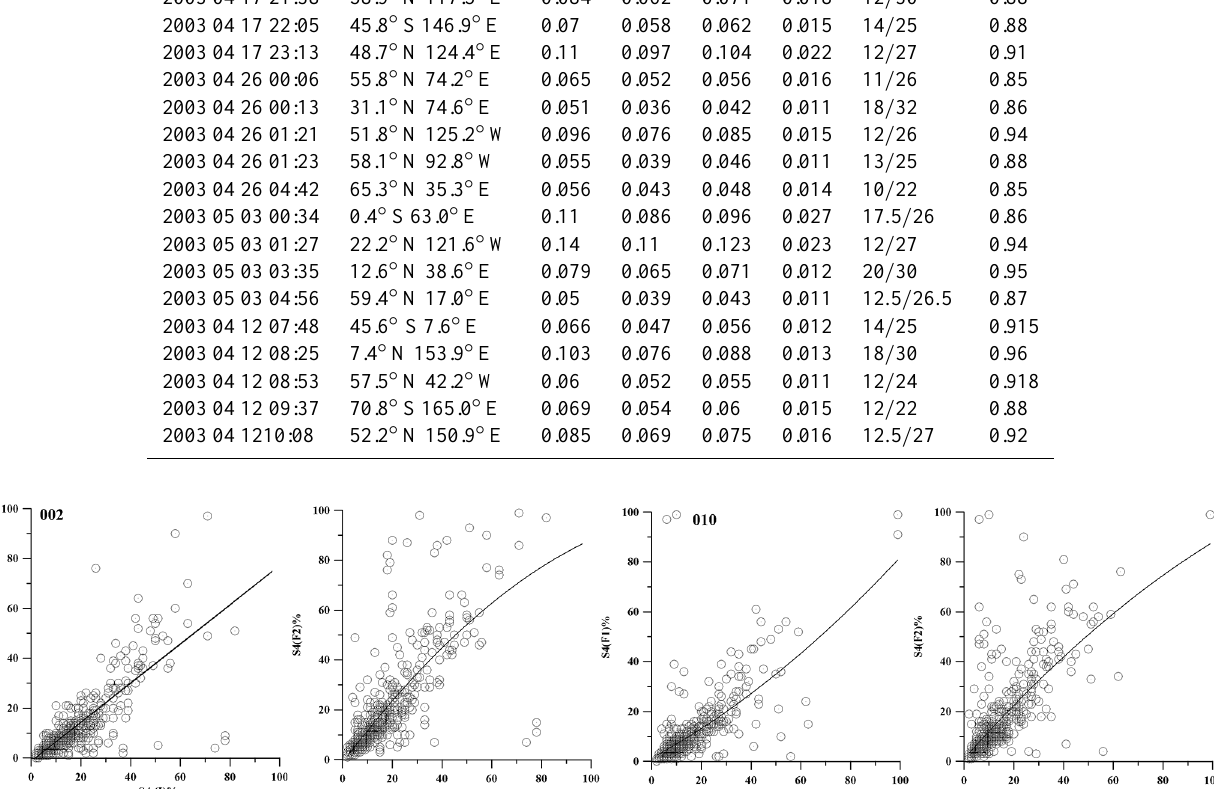
Figure 7. Correlation of index S4(I) measured from the intensity variations of the GPS RO signal at frequency F1 and parameters S4(F1) and S4(F2) found from the eikonal variations at GPS frequencies F1 and